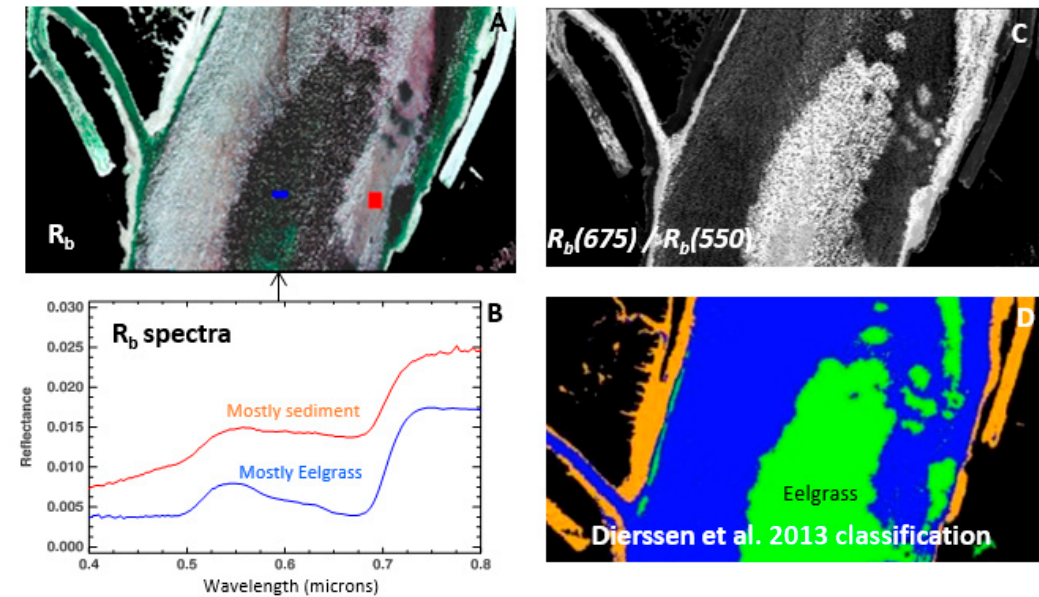
Figure 11. ( A ) Benthic reflectance retrieved over the Vierra bed retrievals shown in pseudo true-color (RGB) and ( B ) the corresponding spectral benthic reflectance across visible wavelengths for pixels identified in Panel A as dominated by eelgrass and sediment. ( C ) Relationship between benthic reflectance at 675 nm and 550 nm related to chlorophyll absorption is a good measure of the extent of the eelgrass bed. ( D ) A similar bed extent was mapped using a tuned chlorophyll-type algorithm with the same PRISM imagery [23].